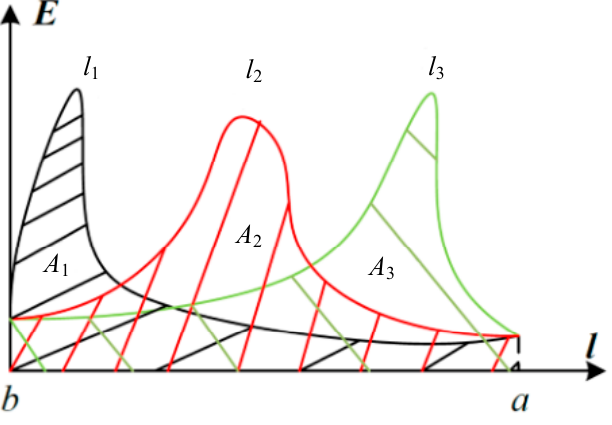
Figure 3. Distribution of the electric field integral of different paths.